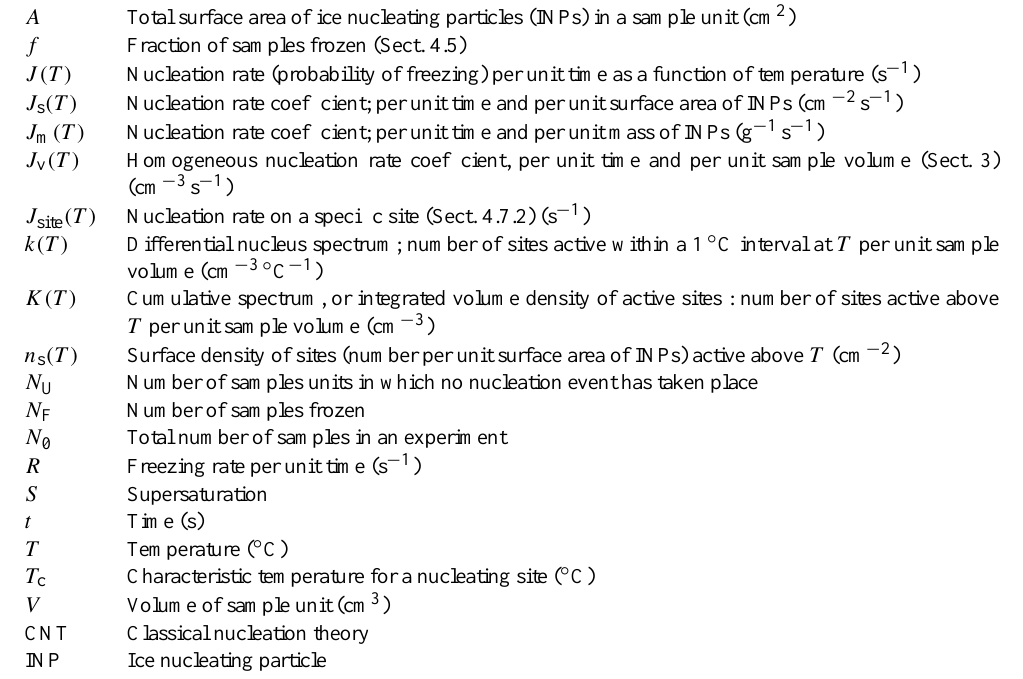
Table 1. List of symbols (with CGS units indicated). A Total surface area of ice nucleating particles (INPs) in a sample unit (cm 2 )